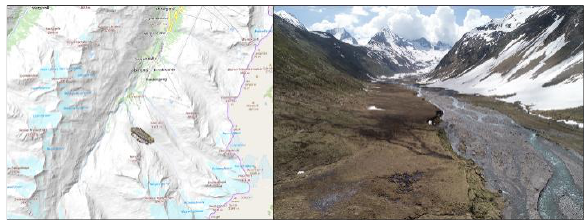
Figure 1. Study area: Rotmoos valley in the Austrian